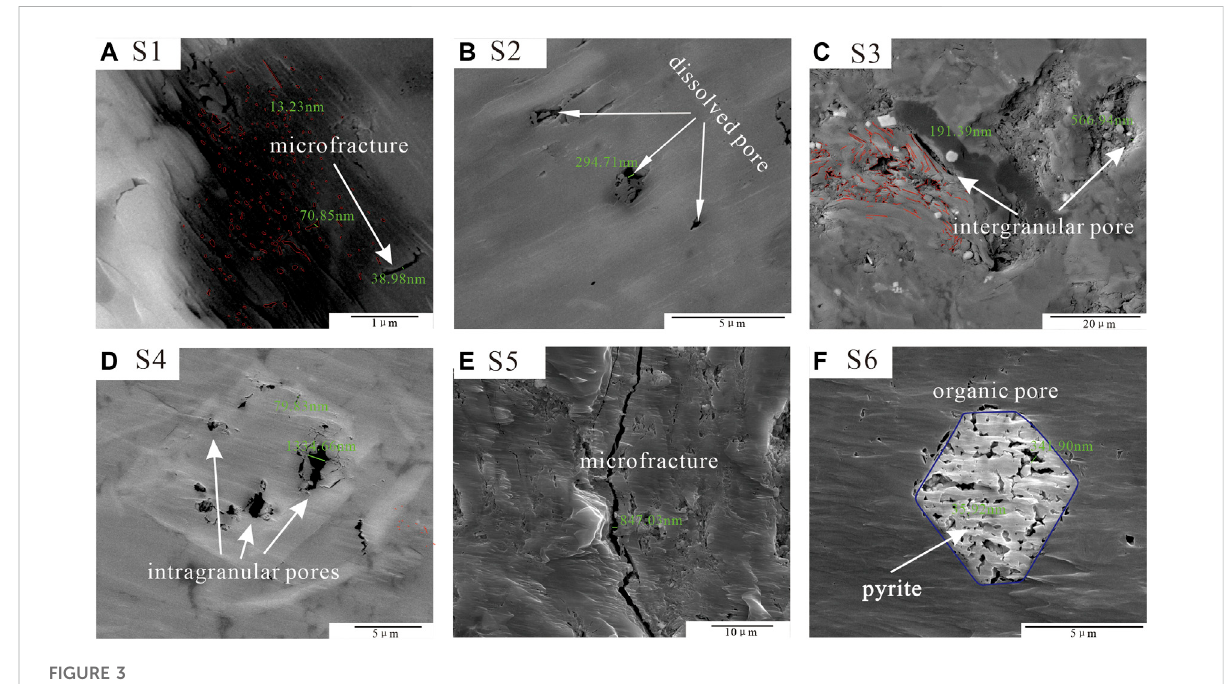
FIGURE 3 SEM results of the Longmaxi shale.